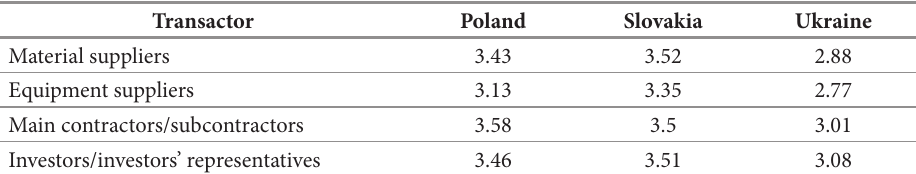
Table 3. The level of partnering relations of construction enterprises with four transactors in the selected regions of three countries